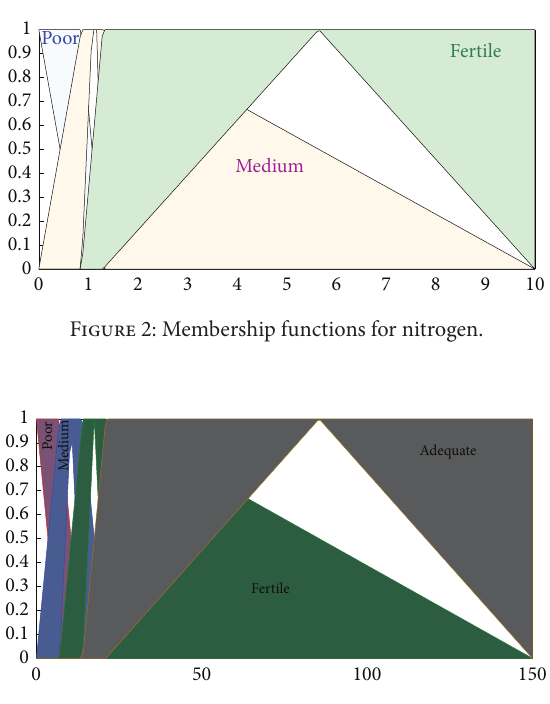
Figure 3: Membership functions for phosphorus.